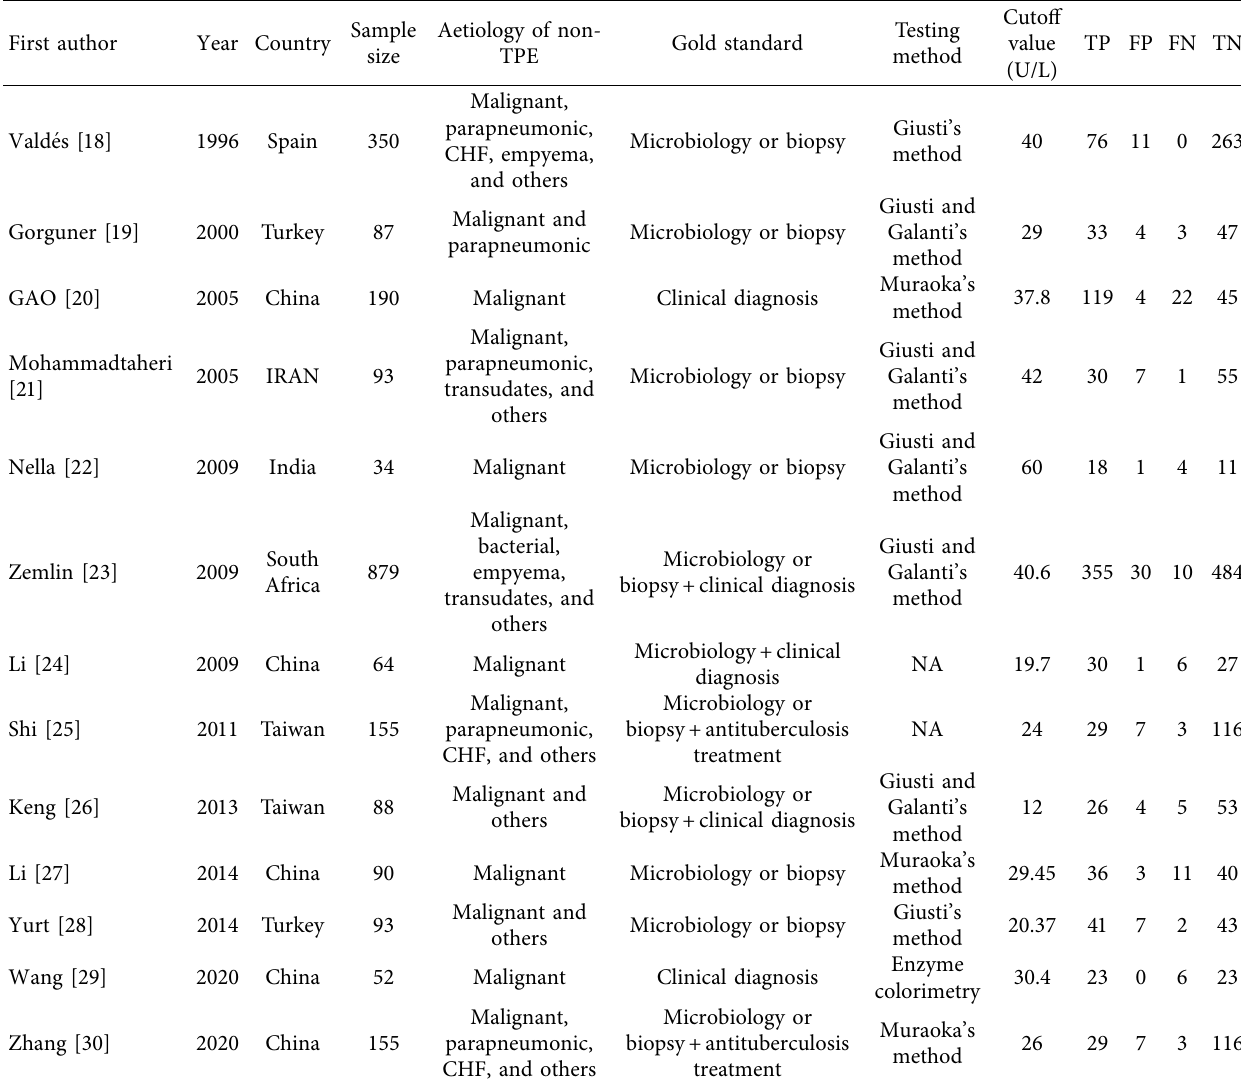
Table 1: A clinical summary of the included